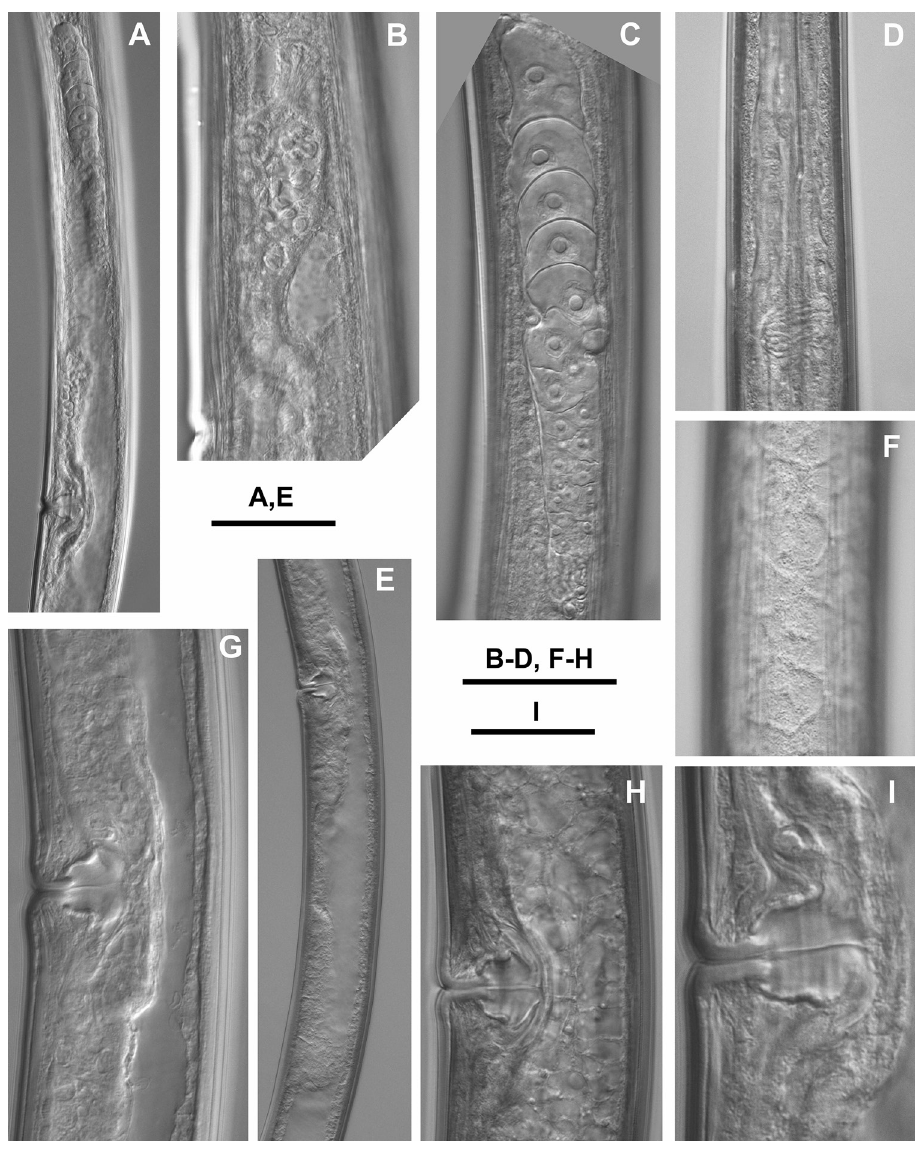
Figure 4. Longidorus piceicola Female from Bran locality: A Anterior genital branch B Uterus part with sperm C Ovary D Nerve ring E Posterior genital branch F Lateral field and epidermal glans G–I Varia- tions in vagina (different magnifications). Scale bars: A, E 80 μm; B–D, F–H 40 μm; I 20